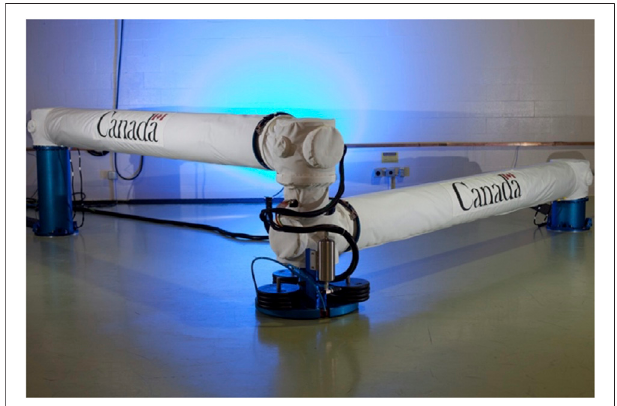
FIGURE 15 | The next-generation Canadarm based on the telescopic link recon fi guration concept